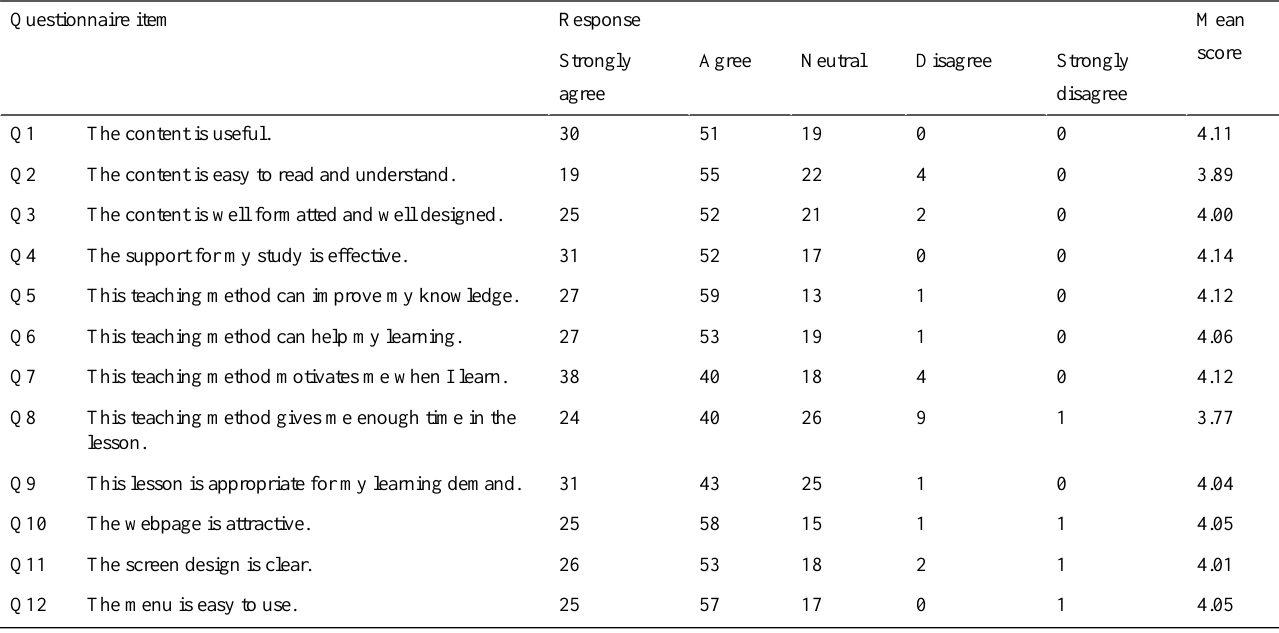
Table 2. Questionnaire scores for content, teaching methods, and Web items (n = 100).